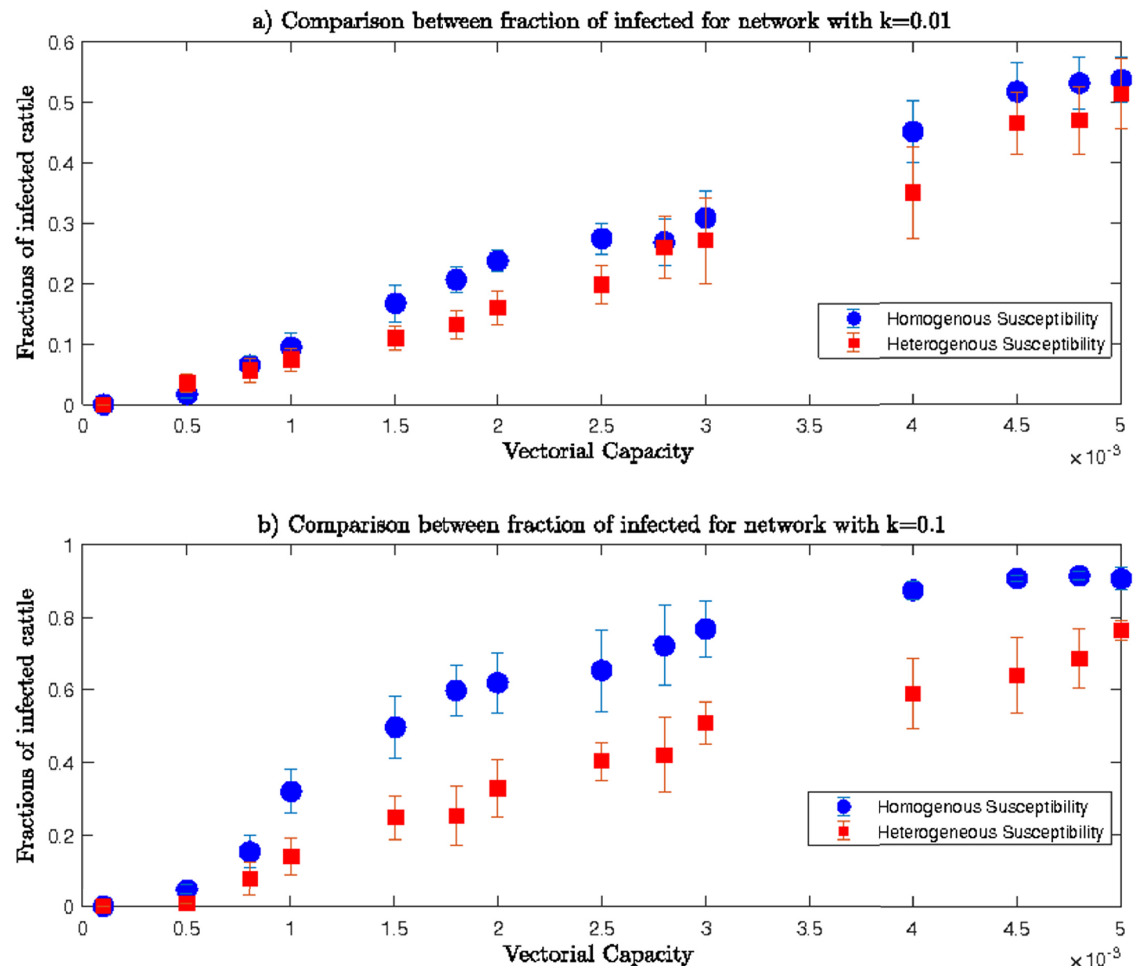
Fig 8. Comparisons among fractions of infected cows for heterogeneous and homogenous networks for lower range of β and a) k = 0.01 and b) k = 0.1.